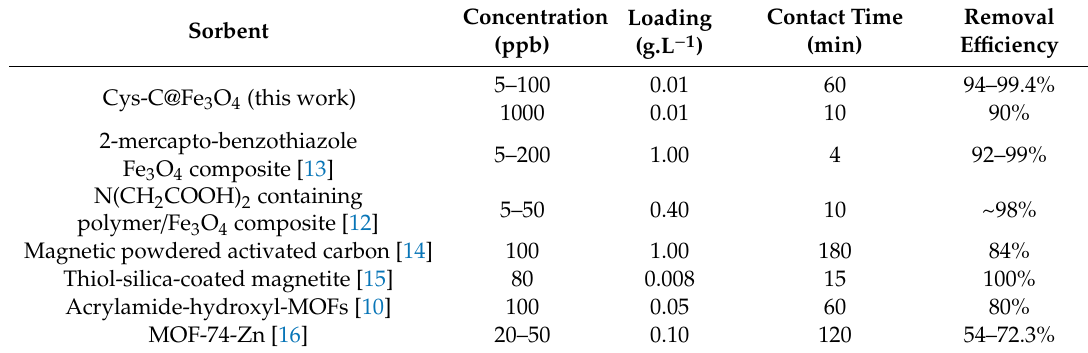
Table 4. Comparison of adsorption capacities of sorbents towards Hg(II) removal from dilute aqueous metal solutions (100 ppb ≥